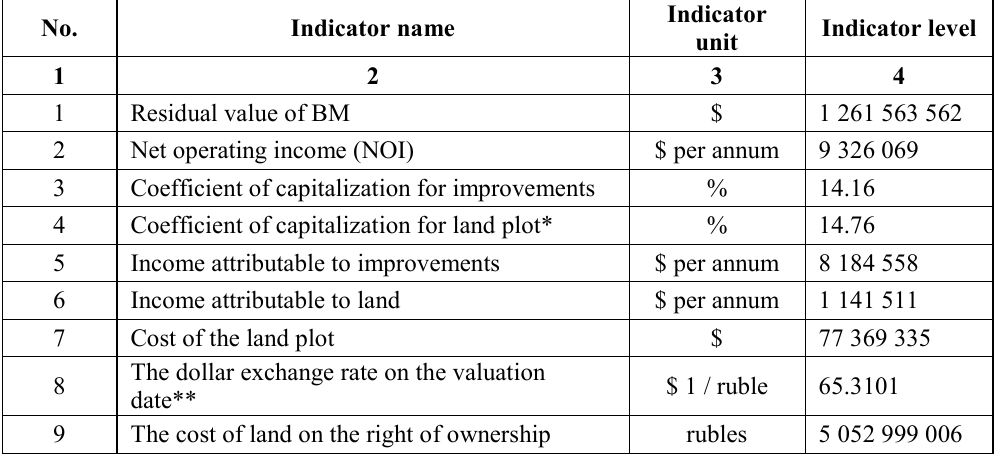
Table 3. Calculation of the Value of Freehold Land (developed by the author) No. Indicator name